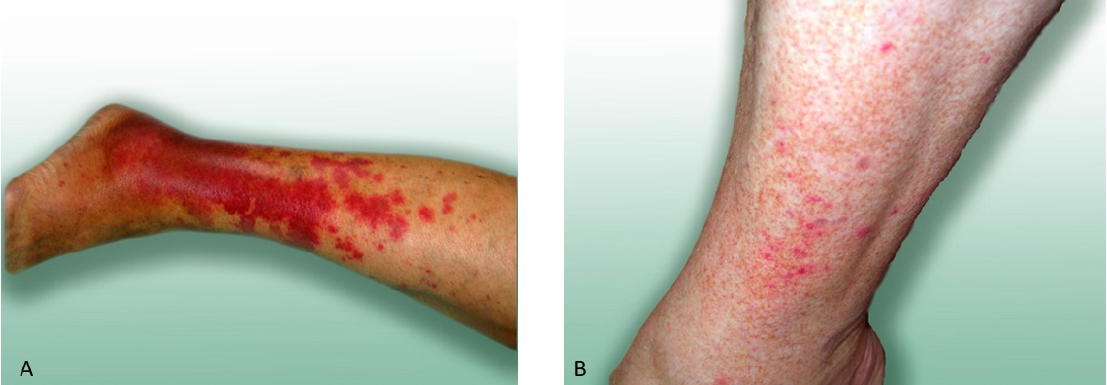
Figure 3. Skin lesions after blackfly bites in patients with co-morbidities. ( A ) Diffuse inflamed erythema on the leg of a patient repeatedly attacked by blackflies (case 1). The purplish color suggests vasculitic skin lesions; ( B ) Papules and vesicles on the shin of a female patient after a single blackfly bite (case 2).